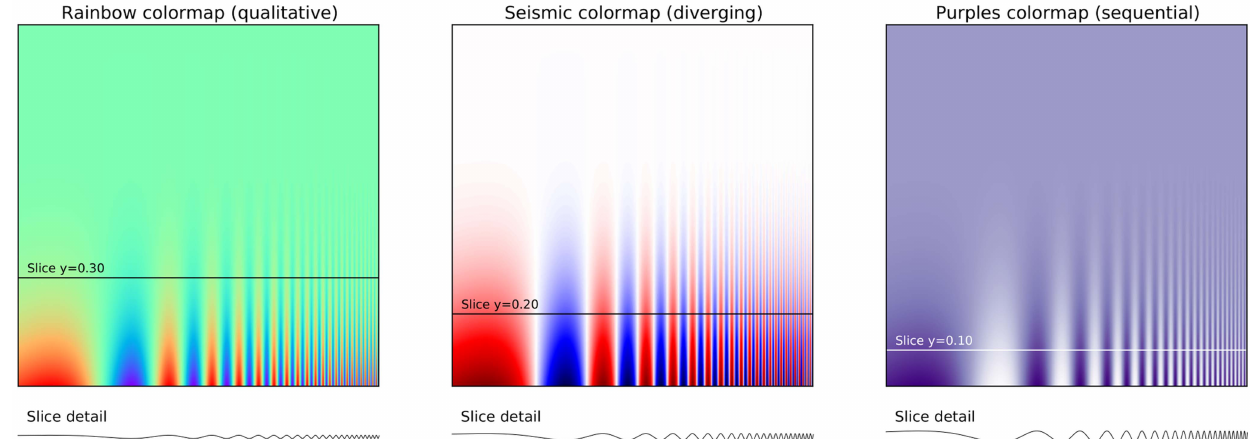
Figure 5. Use color effectively. This figure represents the same signal, whose frequency increases to the right and intensity increases towards the bottom, using three different colormaps. The rainbow colormap (qualitative) and the seismic colormap (diverging) are equally bad for such a signal because they tend to hide details in the high frequency domain (bottom-right part). Using a sequential colormap such as the purple one, it is easier to see details in the high frequency domain. Adapted from [5].